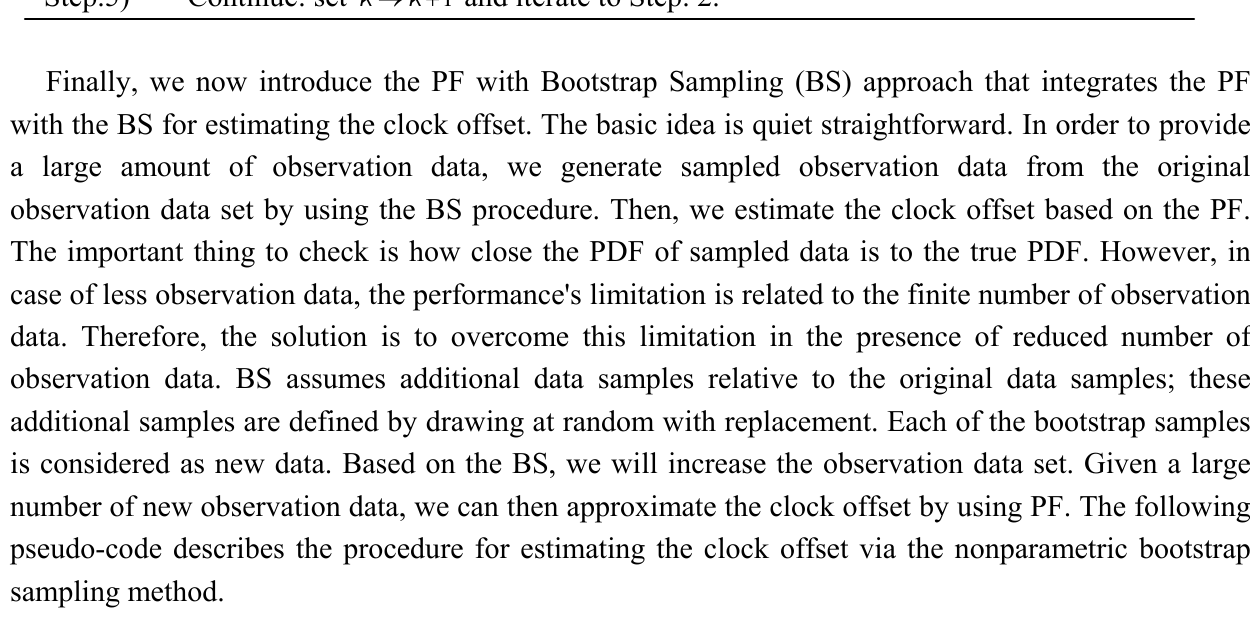
Algorithm 2 . PF with BS